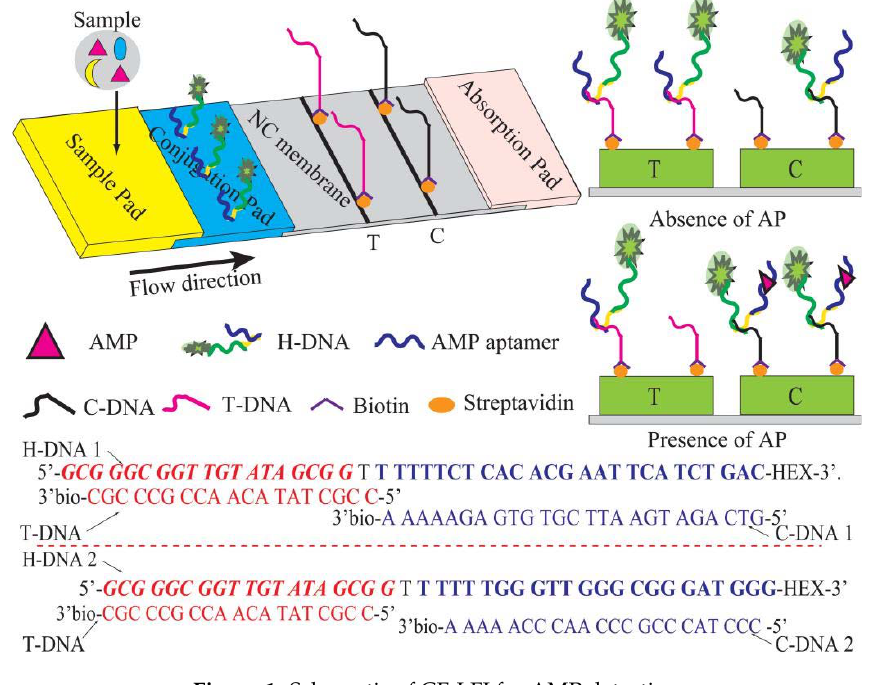
Figure 1. Schematic of CF ‐ LFI for AMP detection.